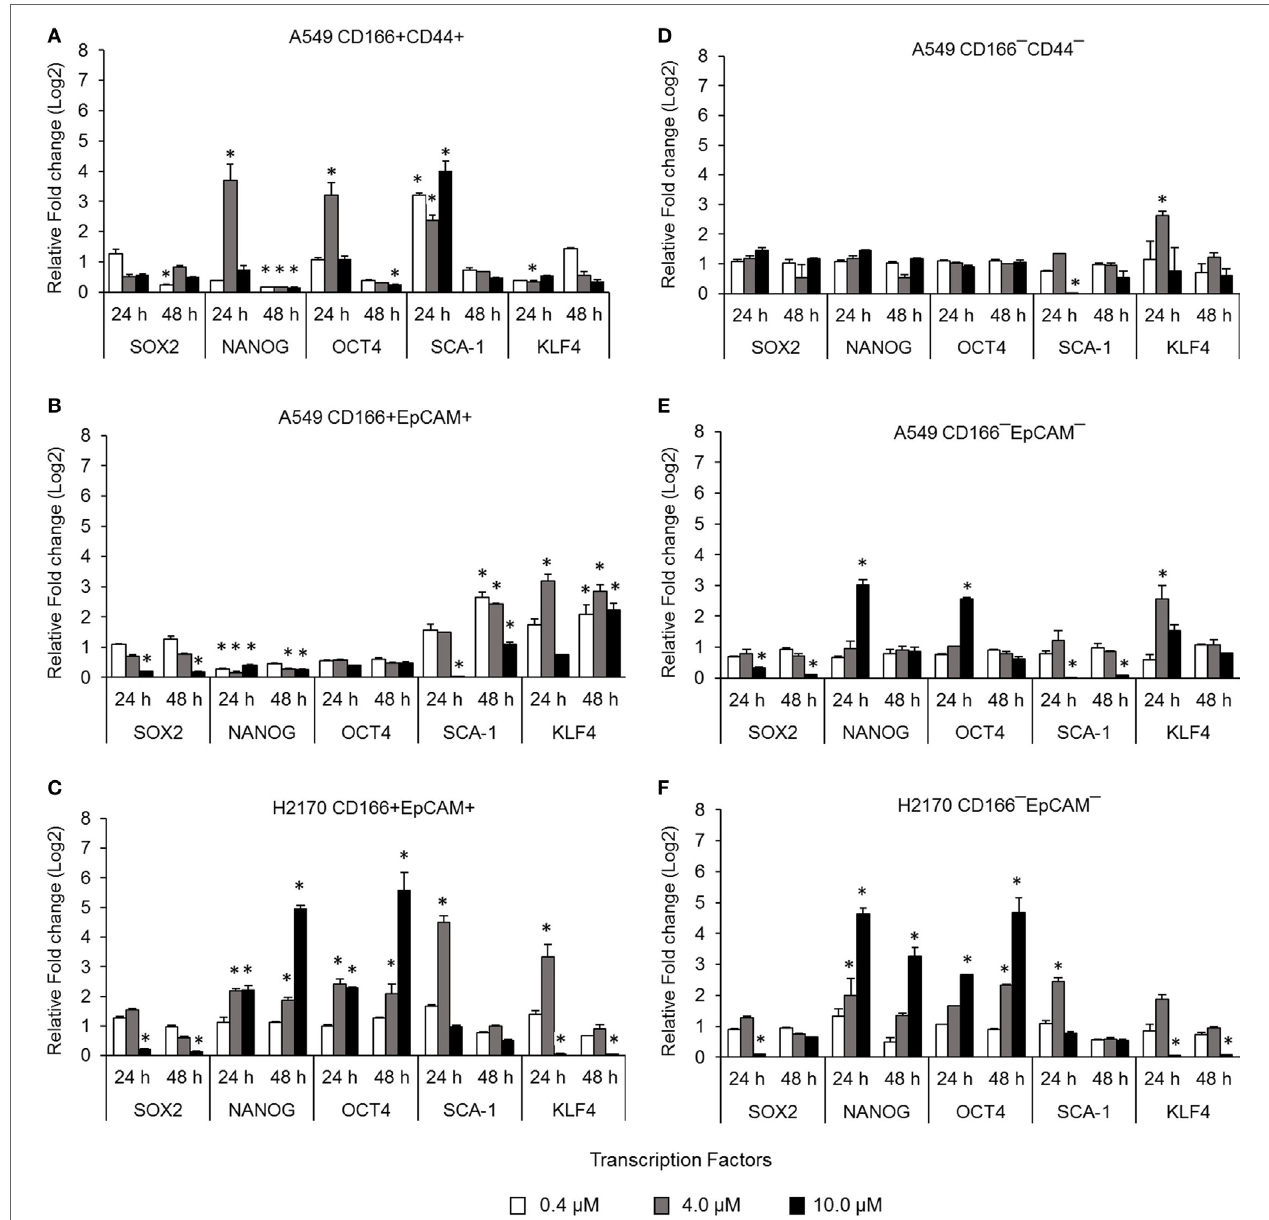
FigUre 1 | Effect of BMS-345541 on expression of stem cell transcription factors in lung cancer stem cells (CSCs). The graphs show the relative expression of stemness genes SOX2 , NANOG , OCT4 , SCA-1 , and KLF4 in (a–c) lung CSC and (D–F) non-CSC populations. The fold change was calculated using the 2 −ΔΔ ct formula, and GAPDH was used as the internal control. Graphs show fold change relative to the untreated sample. The results represent the mean ± SD of three replicates. The p -value was calculated using analysis of variance by comparing the treatment groups with the untreated group (* p <